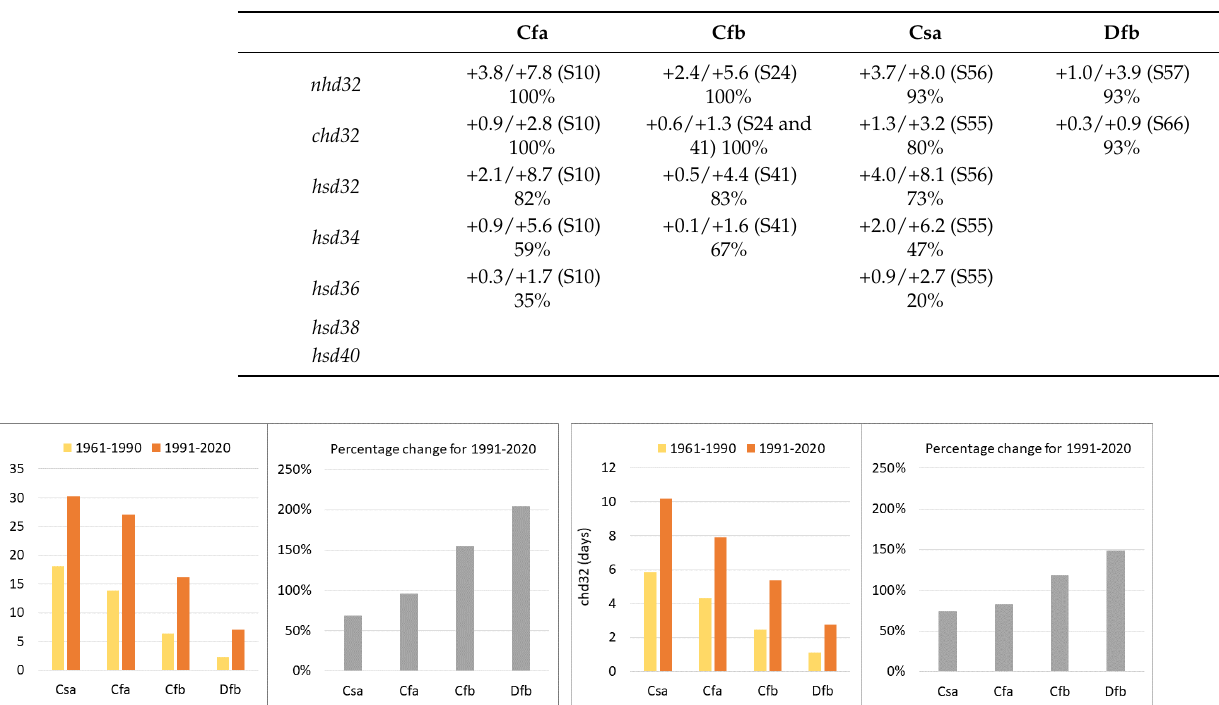
Table 2. Average/maximum values of Sen’s slope estimates (unit: days/10 years) of statistically significant linear trends ( p < 0.05, Mann-Kendall method) of threshold indicators in the period 1961–2020 by zones of the Köppen–Geiger climate classification; the values < 0.1 days/10 years are not presented; stations’ IDs (see Appendix A, Table A1) are shown in brackets, in which maximum values are reached; percentage of stations with statistically significant trends is also shown.